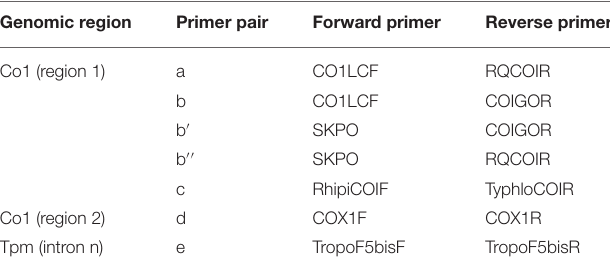
TABLE 3 | Primer pairs used to obtain new sequences in the present study.